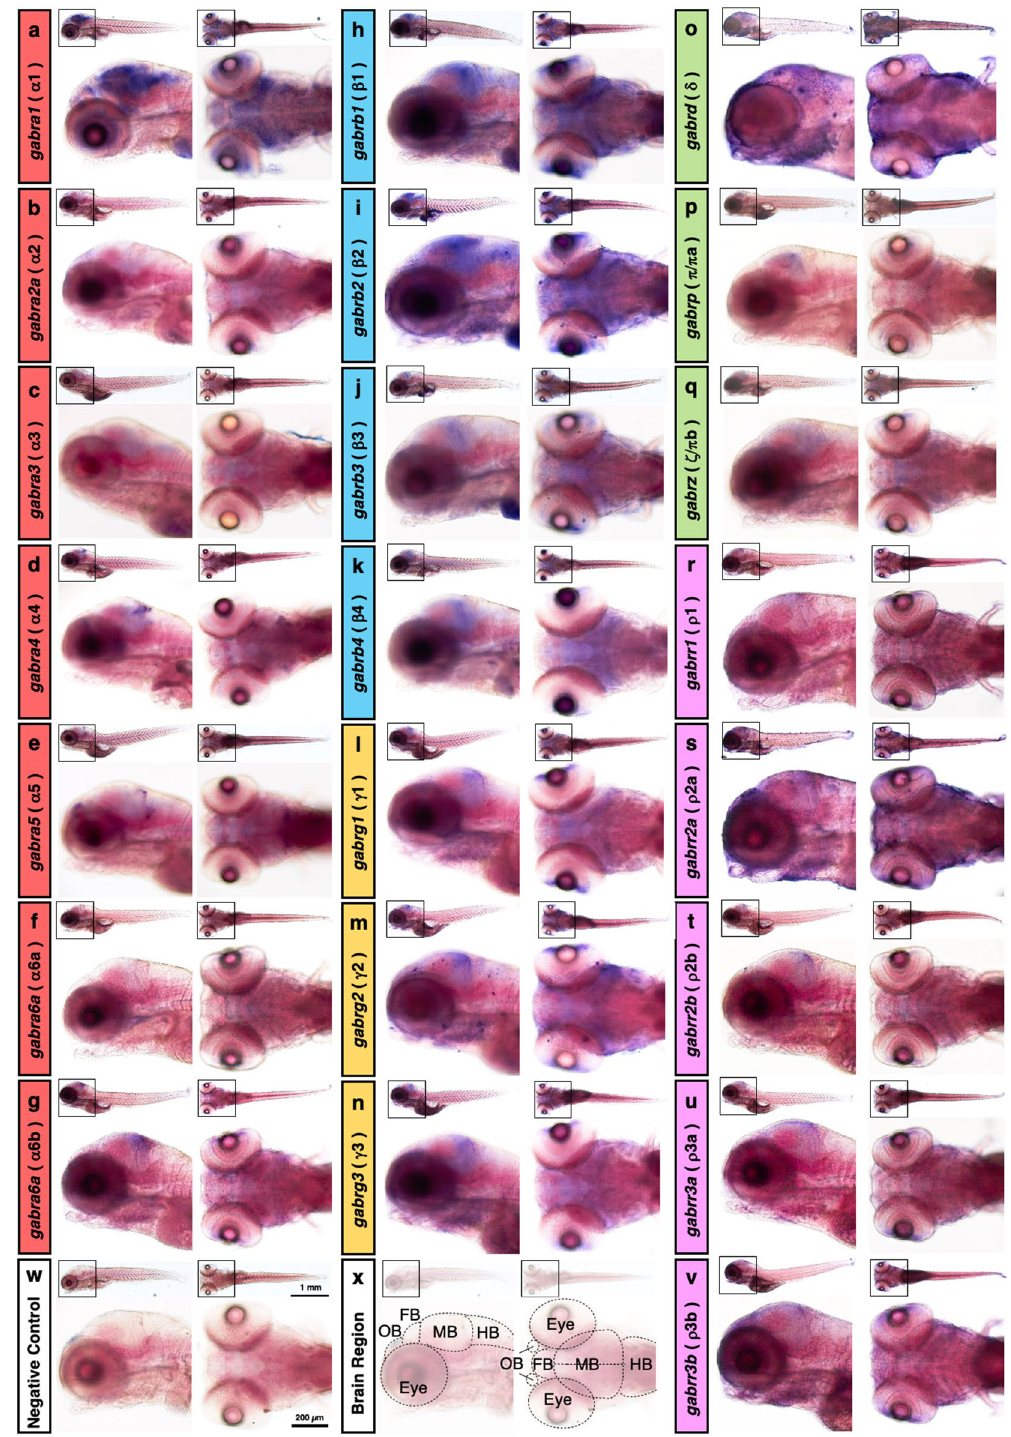
Figure 2. Spatial expression of zebrafish GABA A receptor subunits. Whole-mount in situ hybridization of 5 dpf zebrafish larvae using antisense probes for gabra1 ( a ), gabra2a ( b ), gabra3 ( c ), gabra4 ( d ), gabra5 ( e ), gabra6a ( f ), gabra6b ( g ), gabrb1 ( h ), gabrb2 ( i ), gabrb3 ( j ), gabrb4 ( k ), gabrg1 ( l ), gabrg2 ( m ), gabrg3 ( n ), gabrd ( o ), gabrp ( p ), gabrz ( q ), gabrr1 ( r ), gabrr2a ( s ), gabrr2b ( t ), gabrr3a ( u ), and gabrr3b ( v ). Negative control without probe showing no signals ( w ). Regions of the olfactory bulb, forebrain, midbrain, hindbrain, and eye are indicated in the image ( x ). Each labeling image is composed of a whole lateral view (left top), a whole dorsal view (right top), a magnified lateral view of the head region (left bottom), and a magnified dorsal view of the head region (right bottom). The scale bars in the whole and magnified views are 1 mm and 200 μm, respectively. OB: olfactory bulb; FB: forebrain; MB: midbrain; HB: